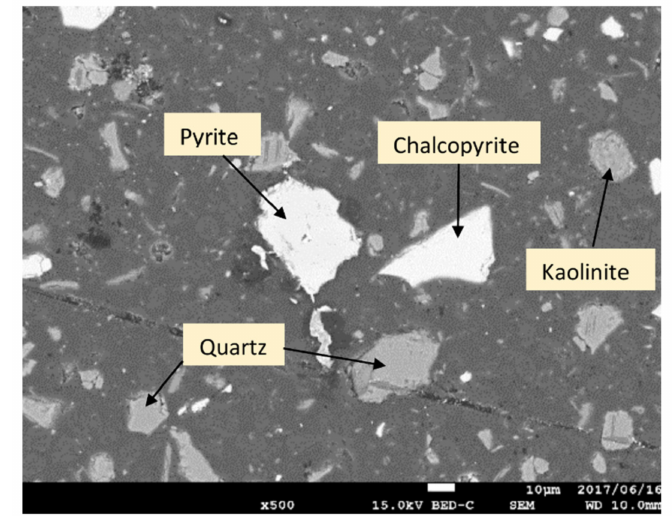
Figure 2. SEM image of the mine tailings from Bor Copper Mine.